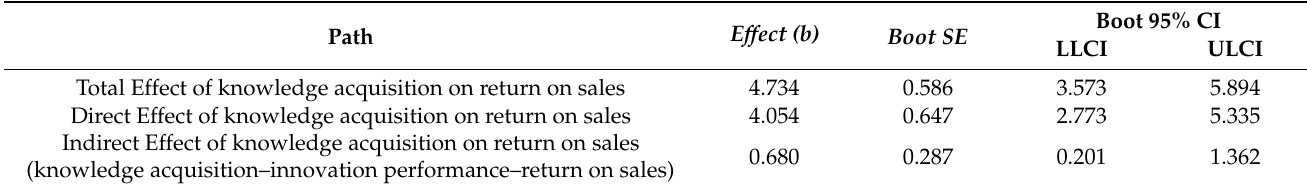
Table A2. Bootstrap significance test for total, direct, and indirect effects of E-E firms’ knowledge acquisition on return on sales.